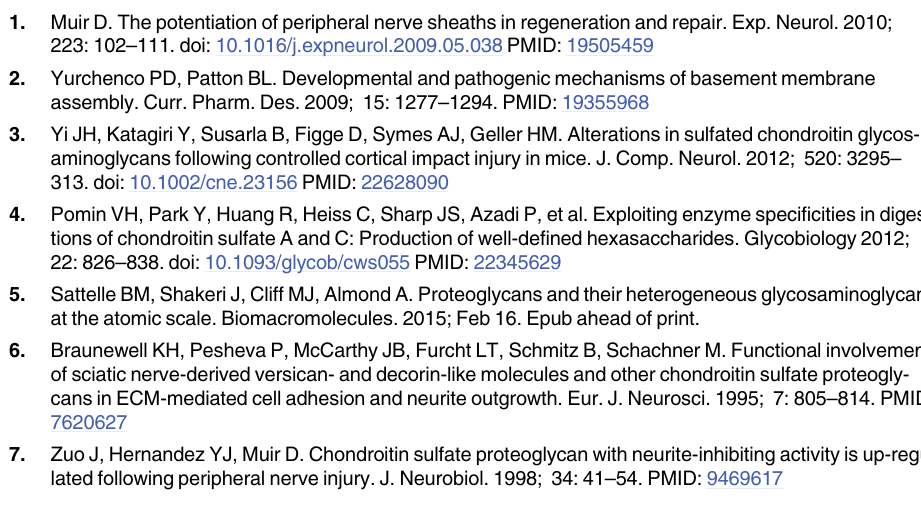
S1 Table. Raw data from cryoculture analysis. Cryoculture axon lengths were measured from the neuron cell body towards the longest neurite. Measurements were congregated based on endoneurial or epineurial growth. Measurements, mean values, standard deviations and standard error of the means were reported as